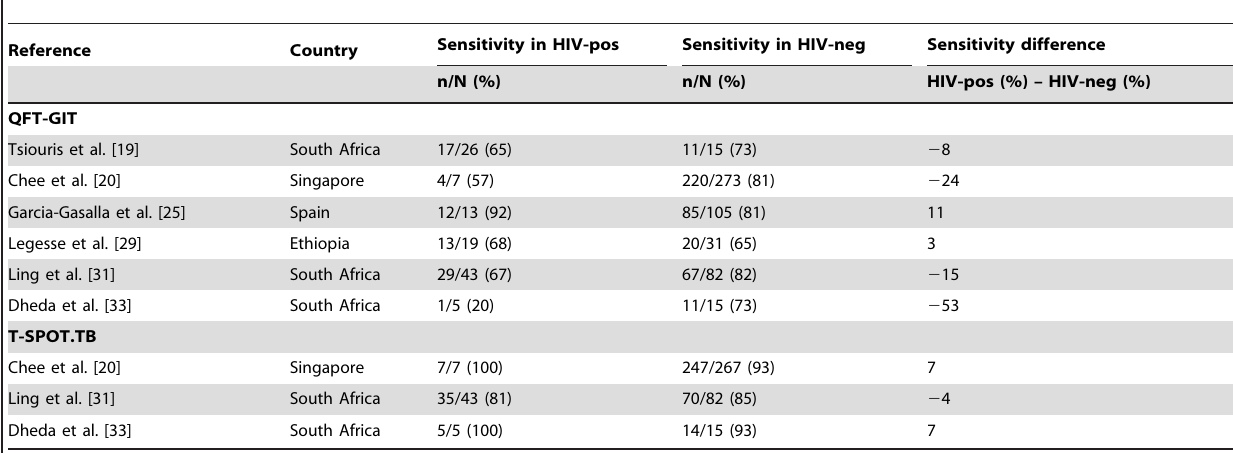
Table 4. Comparison of sensitivity of IGRAs between HIV-infected and HIV-uninfected patients with culture-confirmed tuberculosis.